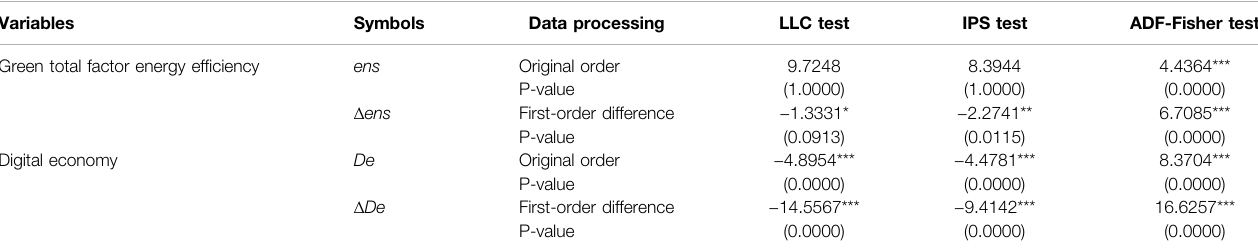
TABLE 6 | Smoothness tests for key